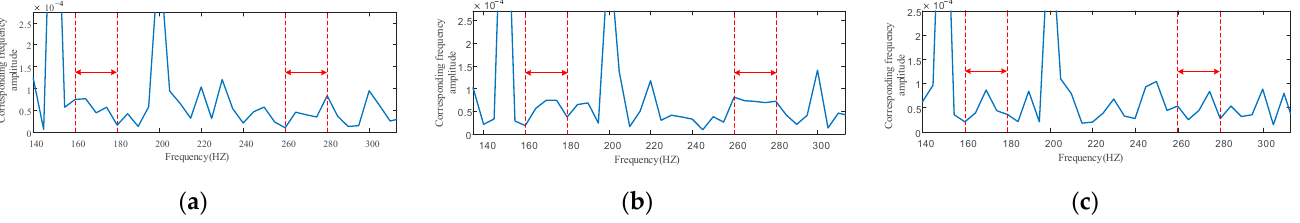
Figure 7. Amplitude frequencies of the normal and arc-resistance grounding fault currents.: ( a ) Nor- mal current amplitudes and frequency characteristics; ( b ) amplitude frequency characteristics when the inter-arc voltage was 160 V and the grounding resistance was 100 ohm; ( c ) amplitude frequency characteristics when the inter-arc voltage was 200 V and the grounding resistance 100 ohm.